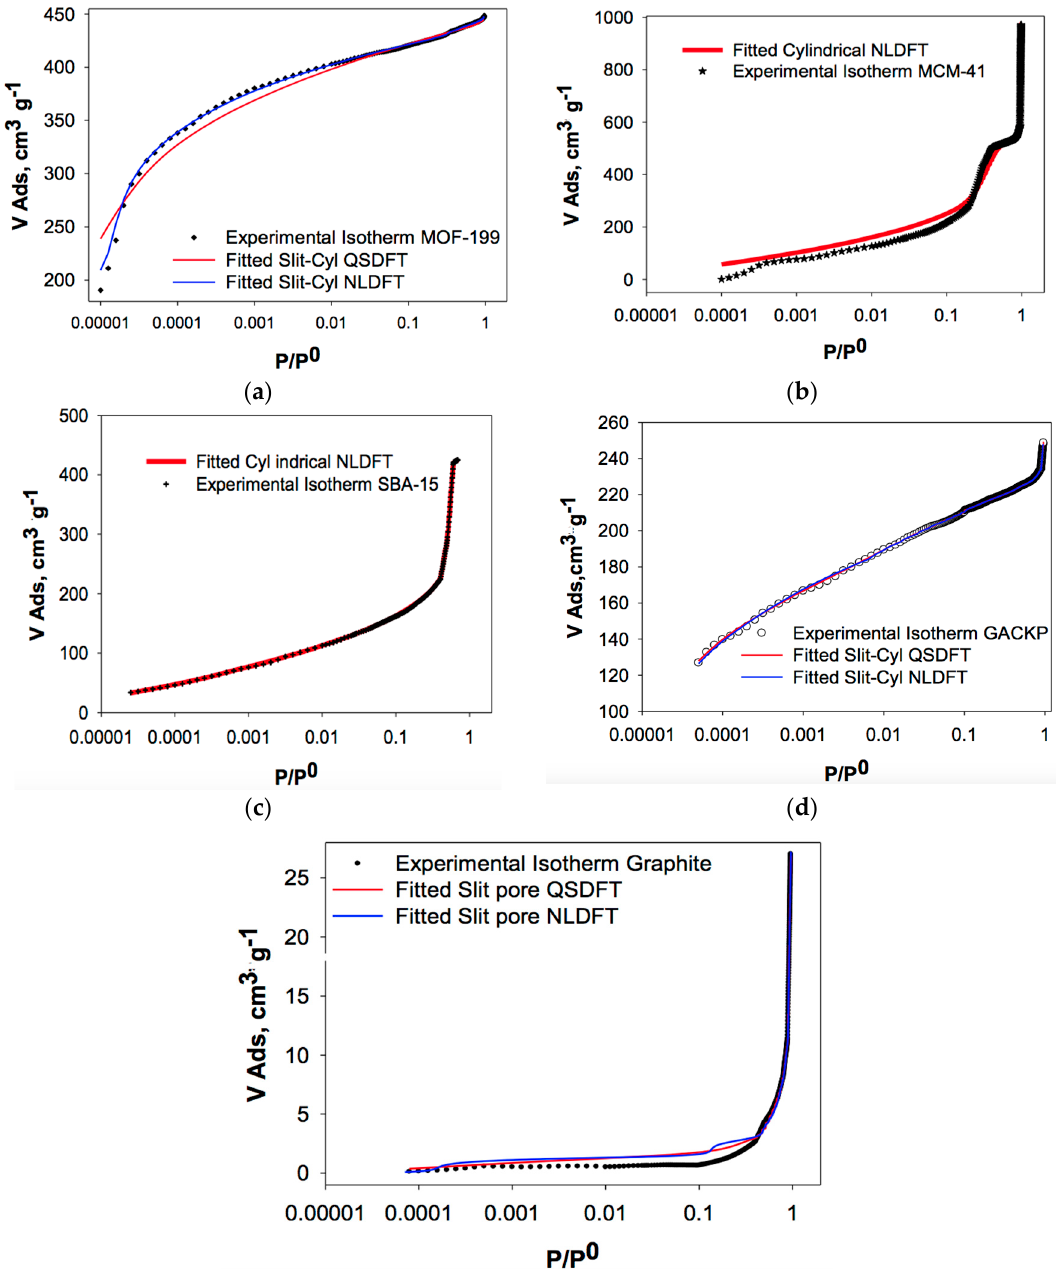
Figure 2. Comparison between QSDFT (Quenched Solid Density Functional Theory) and NLDFT (Non-Local Density Functional Theory) models for nitrogen adsorption of samples prepared in this work. Experimental isotherms and fitted models plotted in logarithmic (semi-scale) for ( a ) MOF-199, ( b ) MCM-41, ( c ) SBA-15, ( d ) GACKP and ( e ) Graphite.